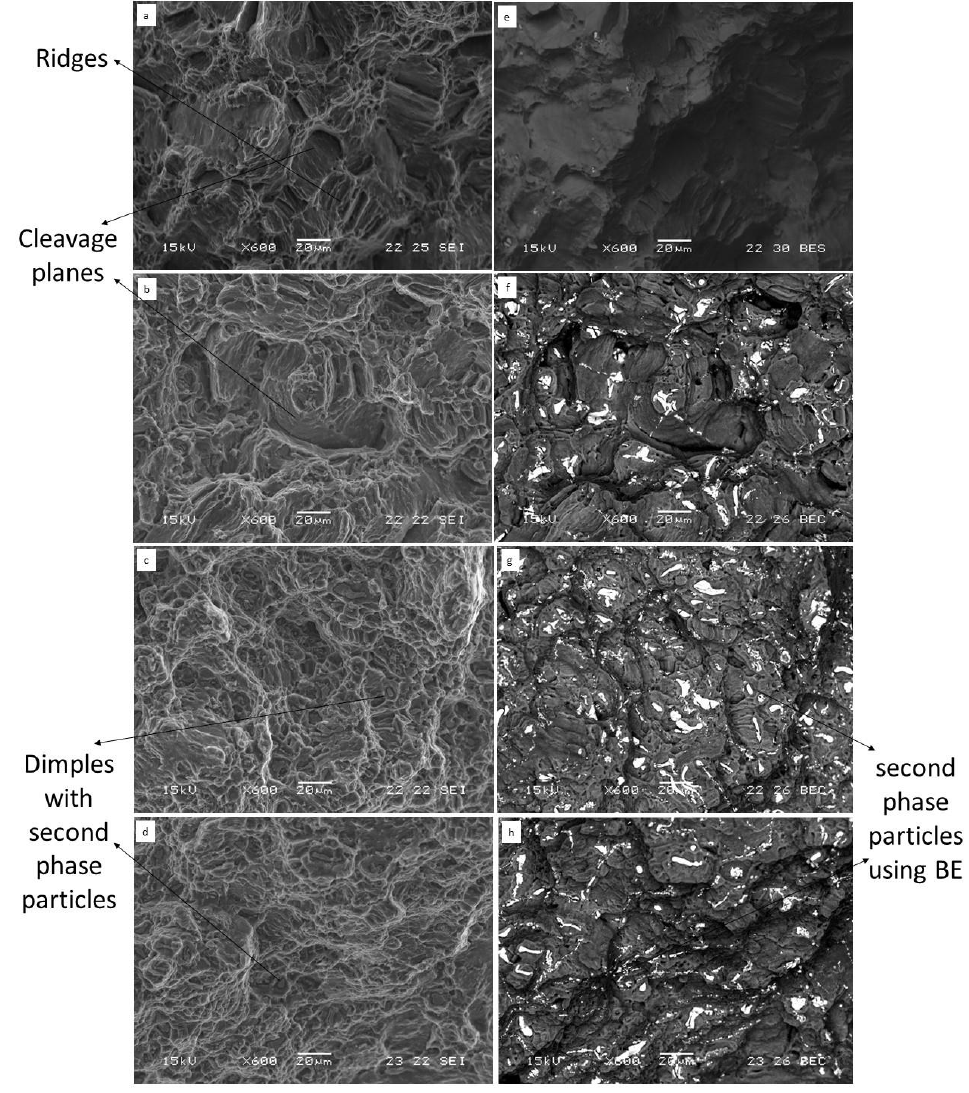
Figure 7. Fractography analysis of tested alloys obtained by scanning electron microscopy (SEM) ( a ) Mg-5%Zn—SE image; ( b ) Mg-5%Zn-1%Nd—SE image; ( c ) Mg-5%Zn-2%Nd—SE image; ( d ) Mg-5%Zn-3%Nd—SE image; ( e ) Mg-5%Zn—BSE image; ( f ) Mg-5%Zn-1%Nd—BSE image; ( g ) Mg-5%Zn-2%Nd—BSE image; ( h ) Mg-5%Zn-3%Nd—BSE